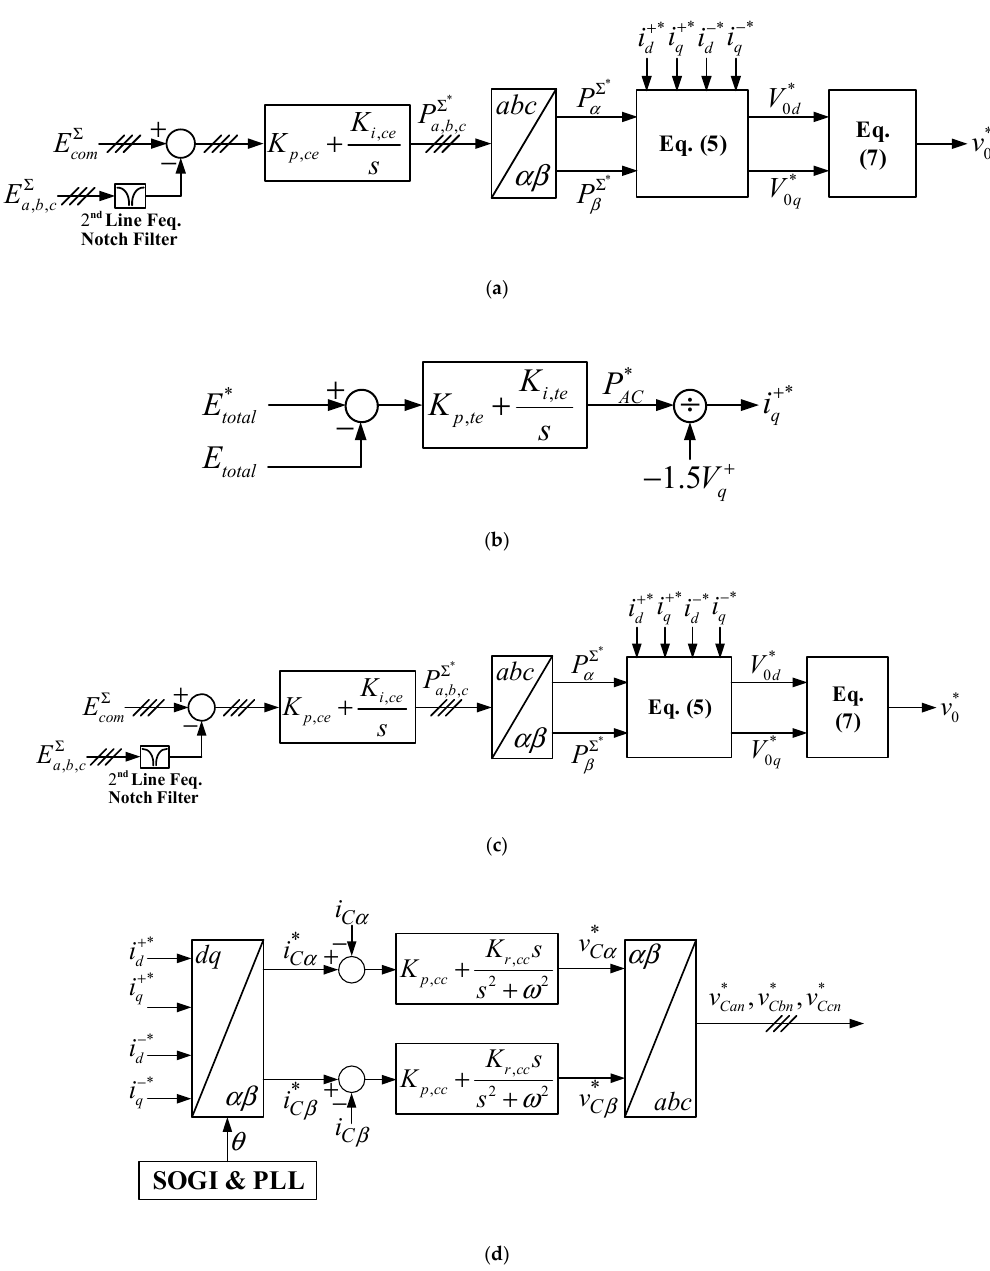
Figure 2. Control block diagram: ( a ) overall control block diagram of wye-connected CHB converter; ( b ) block diagram of total energy controller; ( c ) block diagram of leg capacitor energy balancing controller; ( d ) block diagram of current con- troller.